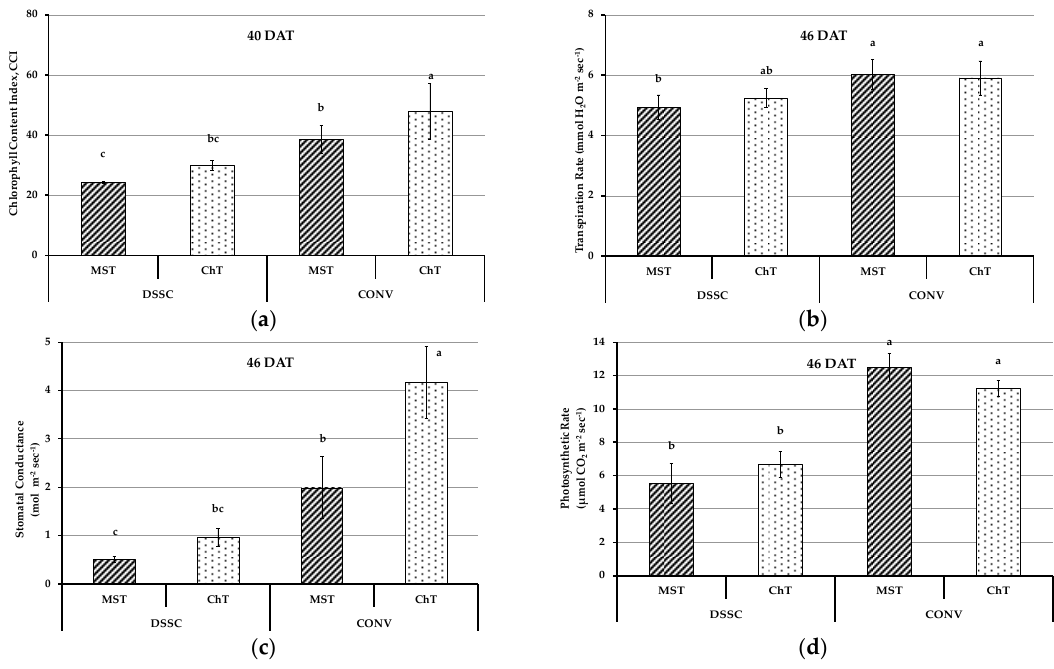
Figure 5. Physiological characteristics of the two tomato hybrids [MST (medium-sized) and ChT (cherry)] in the two greenhouses [DSSC (Dye-Sensitized Solar Cell) and CONV (Conventional)] 40 and 46 days after transplanting (DAT): ( a ) Leaf chlorophyll content; ( b ) transpiration rate; ( c ) stomatal conductance; ( d ) photosynthetic rate. Bars with different letters were significantly different by LSD at P ≤ 0.05. Table 3. Combined variance analysis of the physiological parameters, as influenced by the greenhouse types [DSSC (Dye-Sensitized Solar Cell) and CONV (Conventional)] and the species of tomato hybrid [MST (medium-sized) and ChT (cherry)].